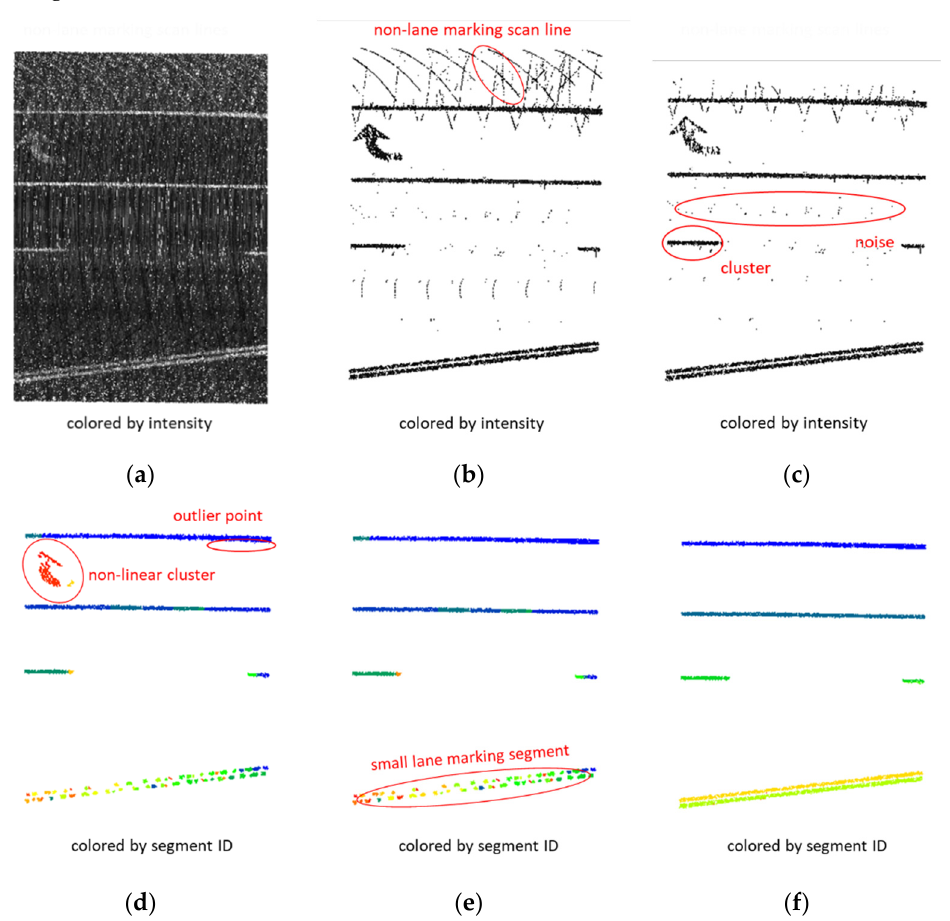
Figure 3. Lane marking extraction strategies: ( a ) road surface block; ( b ) hypothesized lane markings; ( c ) lane marking points after the scan line-based outlier removal; ( d ) lane marking segments after density-based spatial clustering; ( e ) lane marking segments after geometry-based outlier removal; ( f ) lane marking segments after local and global refinements.